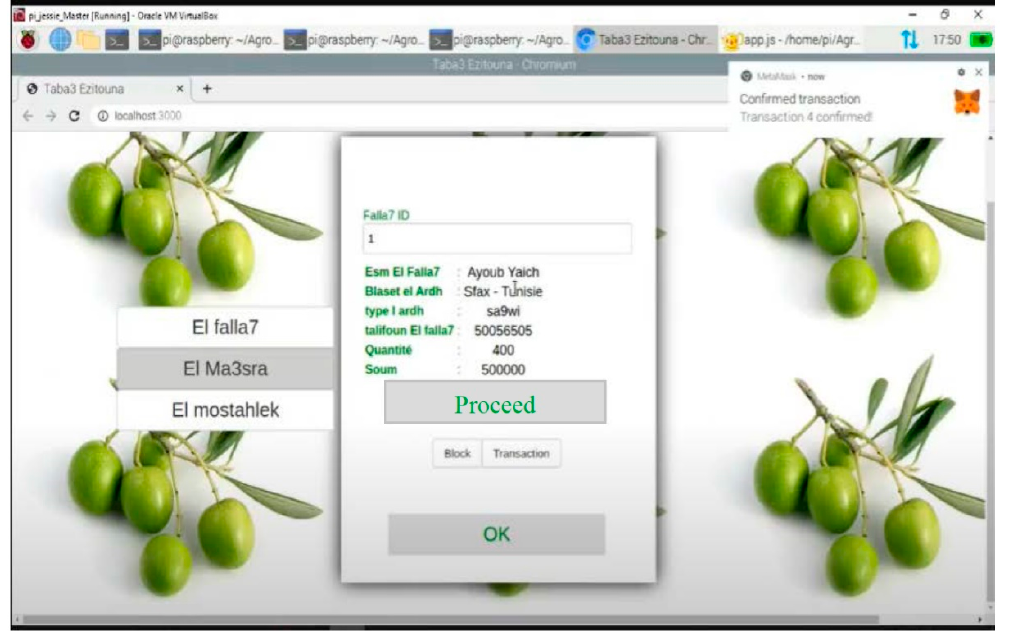
Figure 13. Monitoring and securing production: oil manufacturer interface.